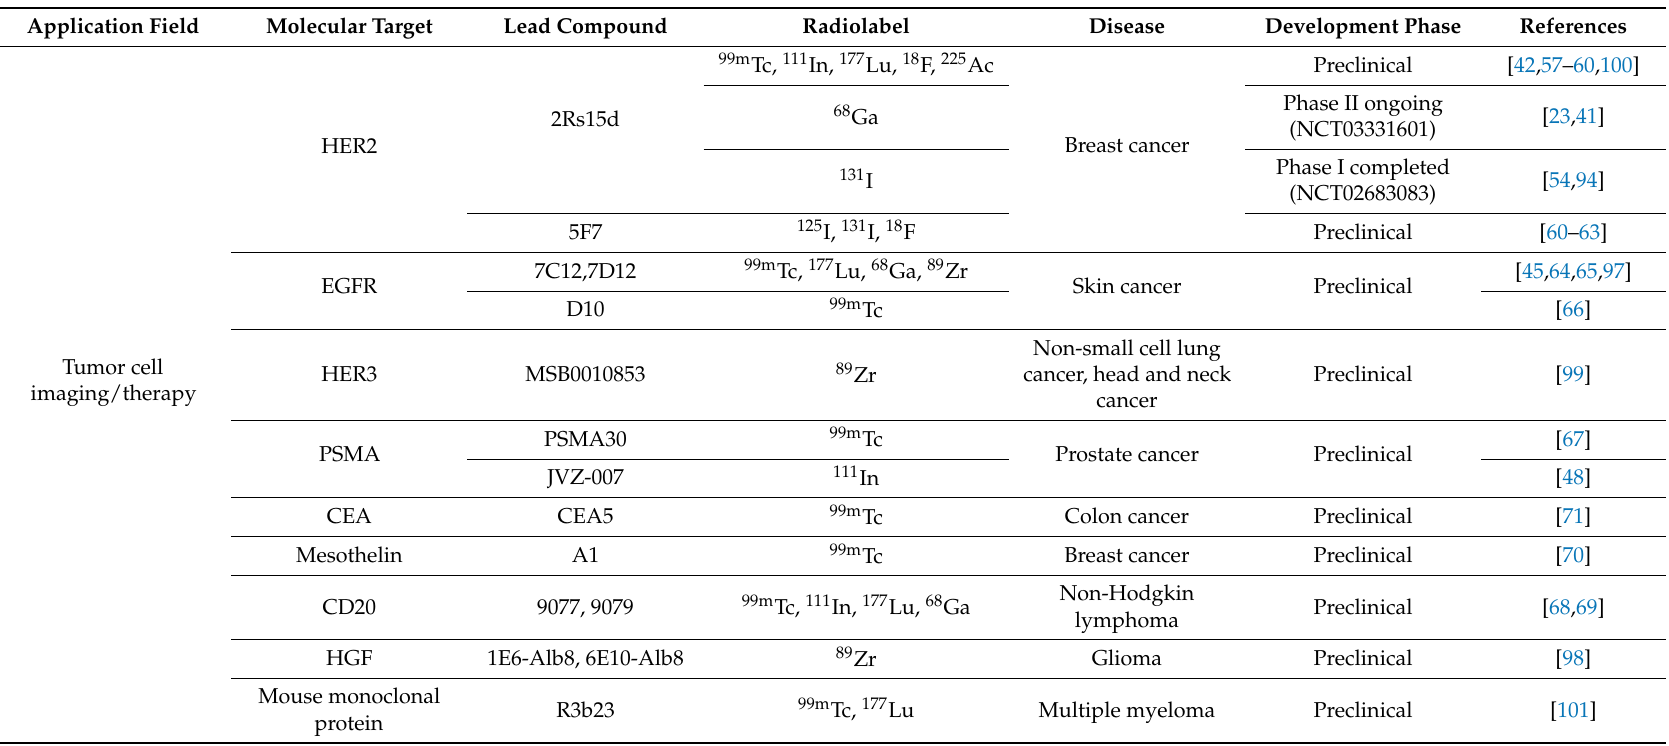
Table 1. Overview of preclinically and clinically tested nanobody-based radiopharmaceuticals with applications in nuclear